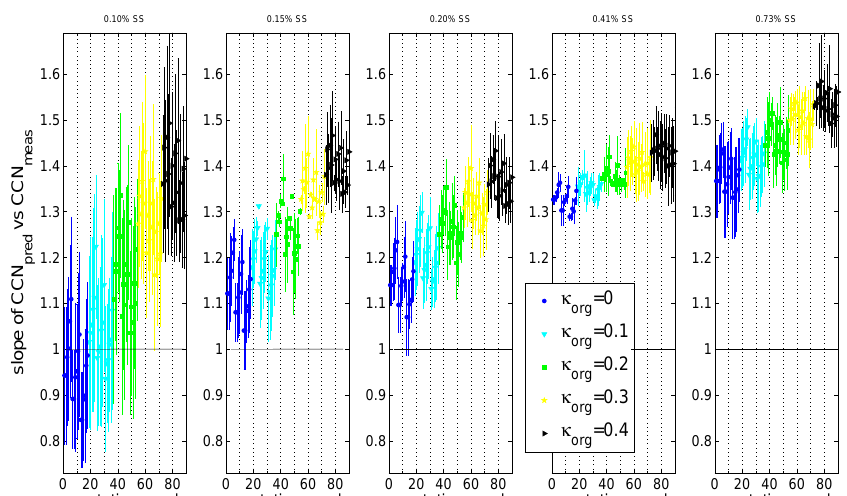
Fig. 3. The fitted slope of CCN pred vs. CCN meas for the different permuted assumptions and each supersaturation.